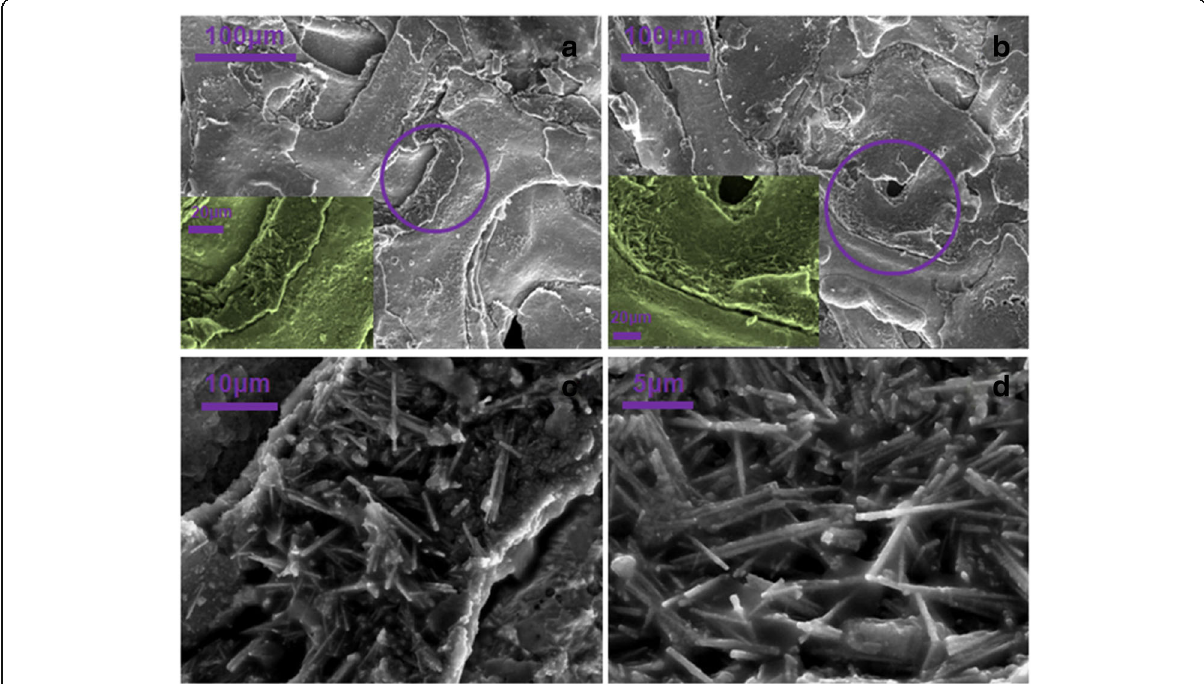
Fig. 2 a SEM image of the tested Co-ClNWs(NiE) electrode. b SEM image of the material embedded in the nickel foam inter layers. c , d SEM images of closely aligned growth on the nickel foam skeleton under high